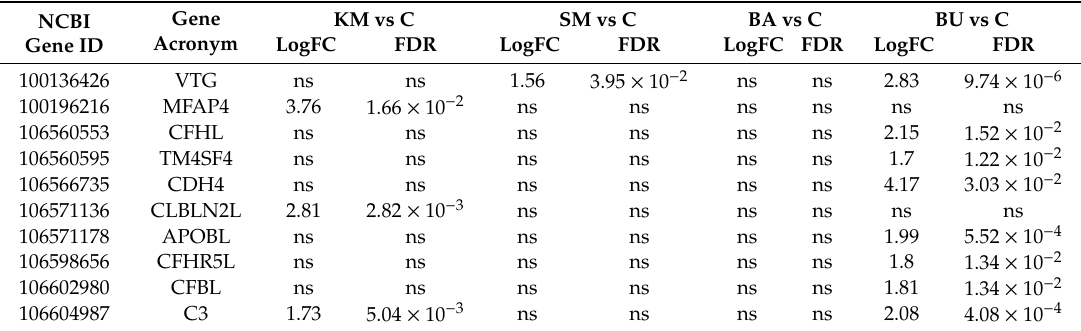
Table 1. SummaryofDEGsintheheadkidneyofthefivedifferentgroupsafter12weeks. ns = notsignificant.